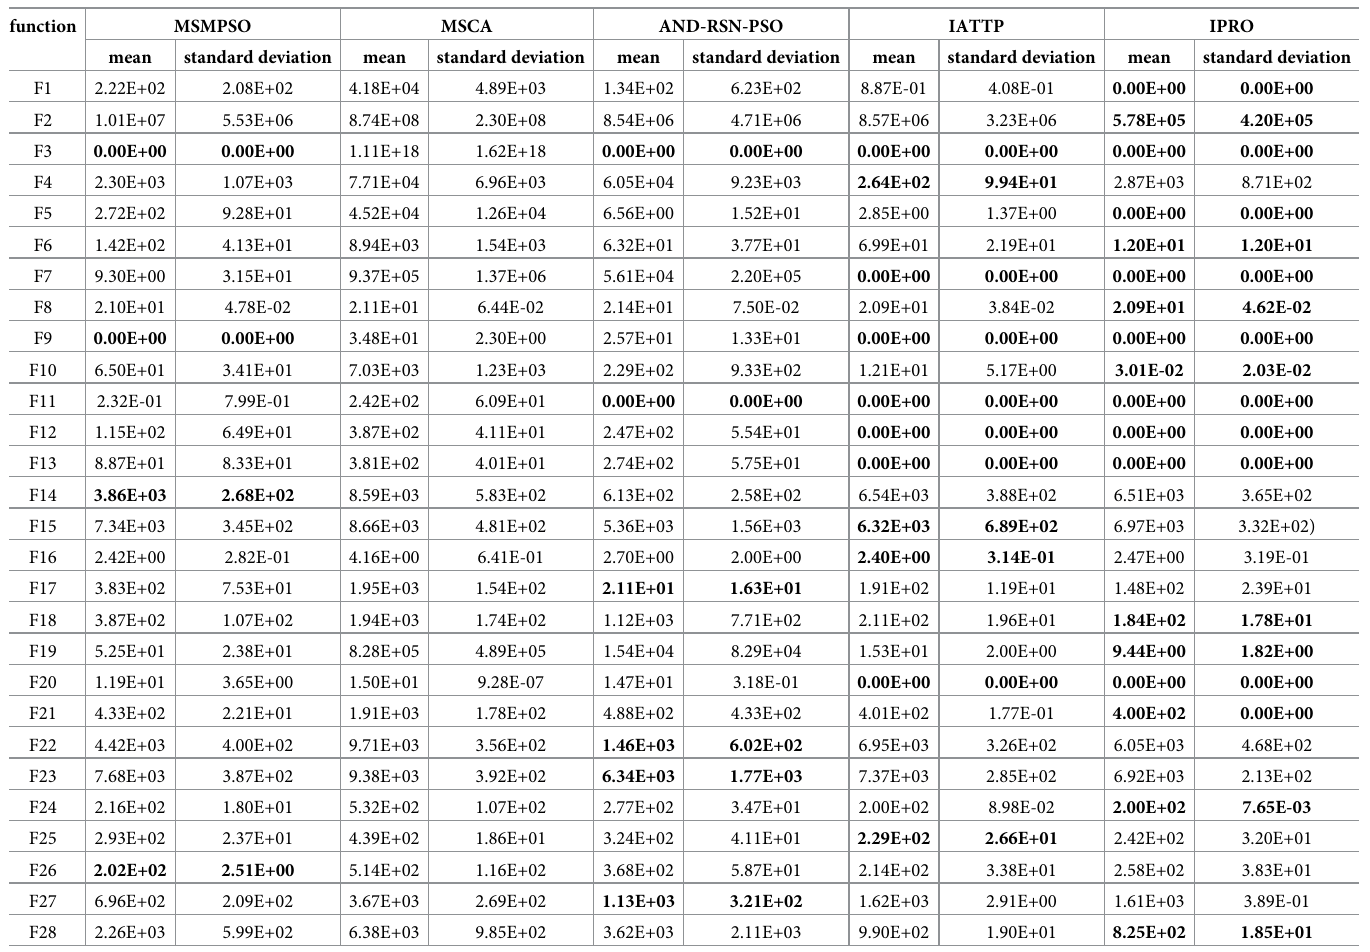
Table 7. Comparison results of 5 algorithms on the 30-dimensional CEC2013 test